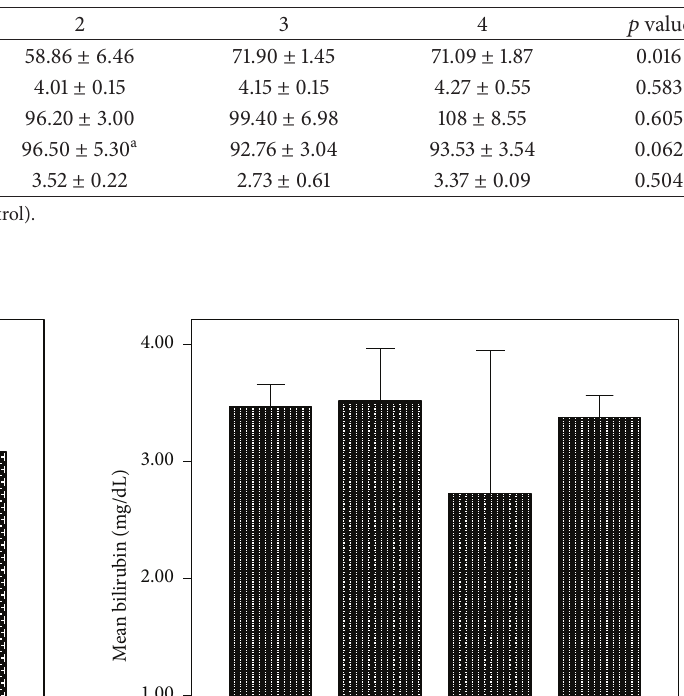
Table 2: In vivo antioxidant activity ad liver parameters expressed in mean ± SE.